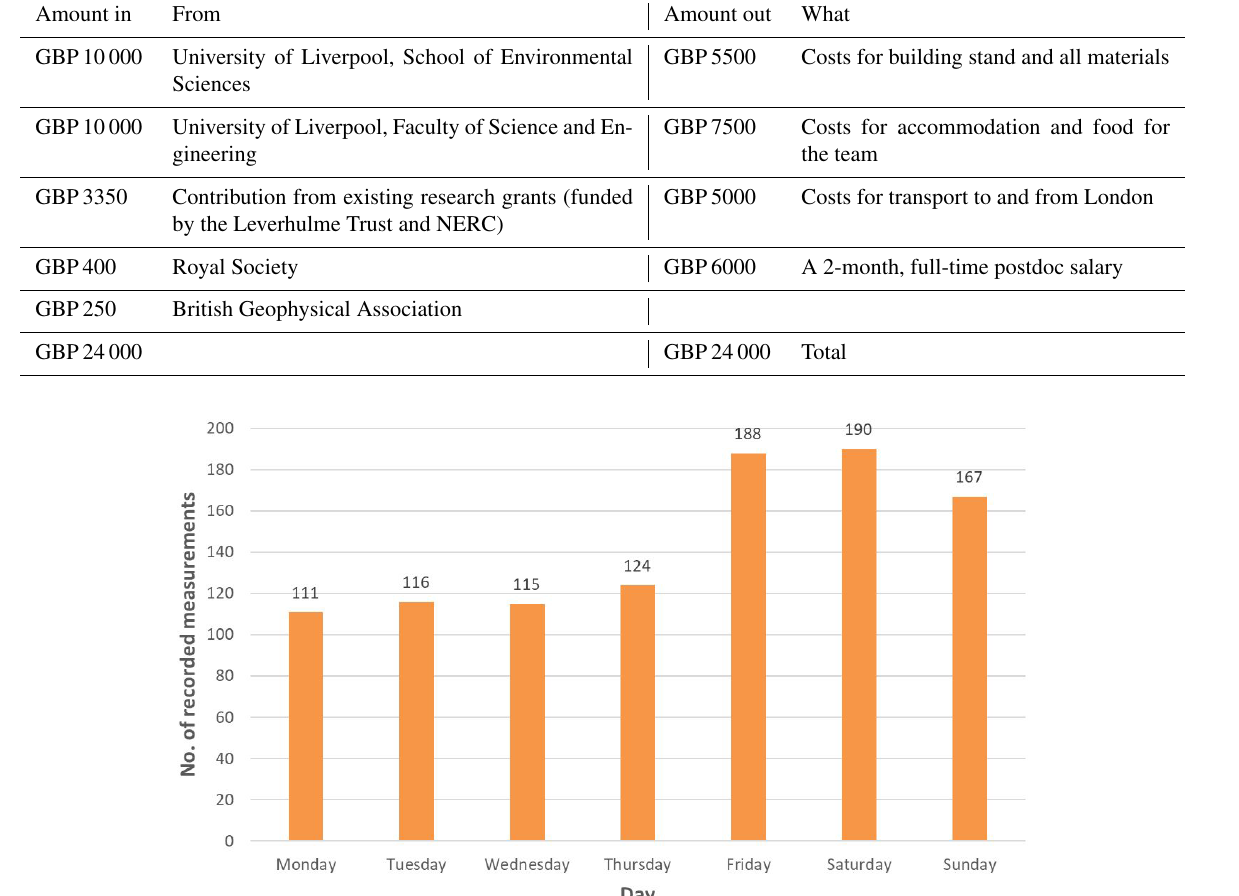
Figure 6. Number of measurements performed on the kickstool magnetometer per day.